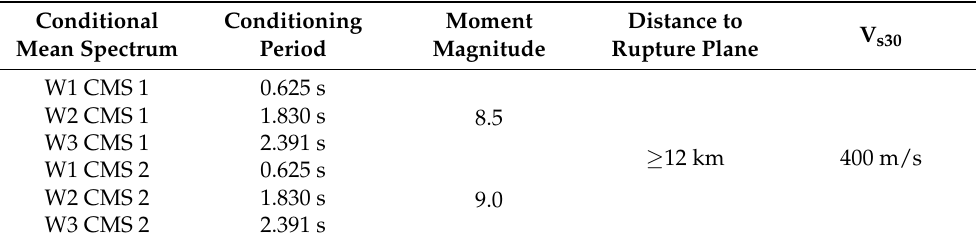
Table 3. Conditions for the construction of the